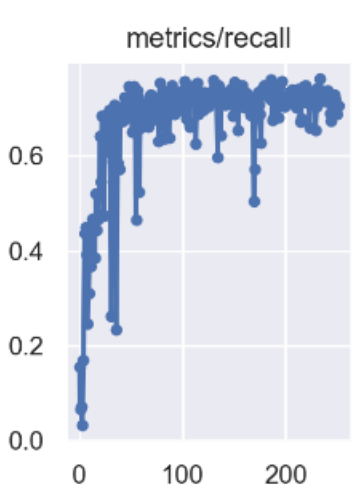
Figure A1. The changes of recall of YOLOV5n.